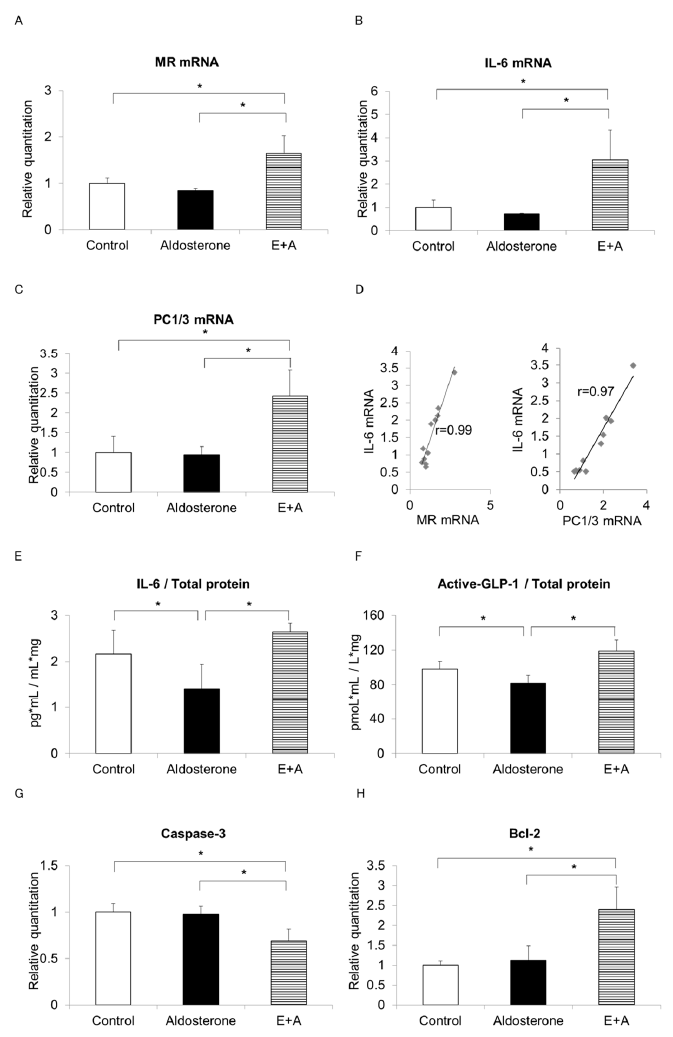
Figure 3. Alteration of mRNA levels and IL-6 and active GLP-1 concentrations in α TC cells. MR mRNA ( A ), IL-6 mRNA ( B ) and PC1 / 3 mRNA ( C ) were measured in α TC cells (p5), treated for 24 h with vehicle (Control), 10 − 7 M aldosterone (Aldosterone) or 10 − 7 M aldosterone after 1 h pre-treatment with 10 − 5